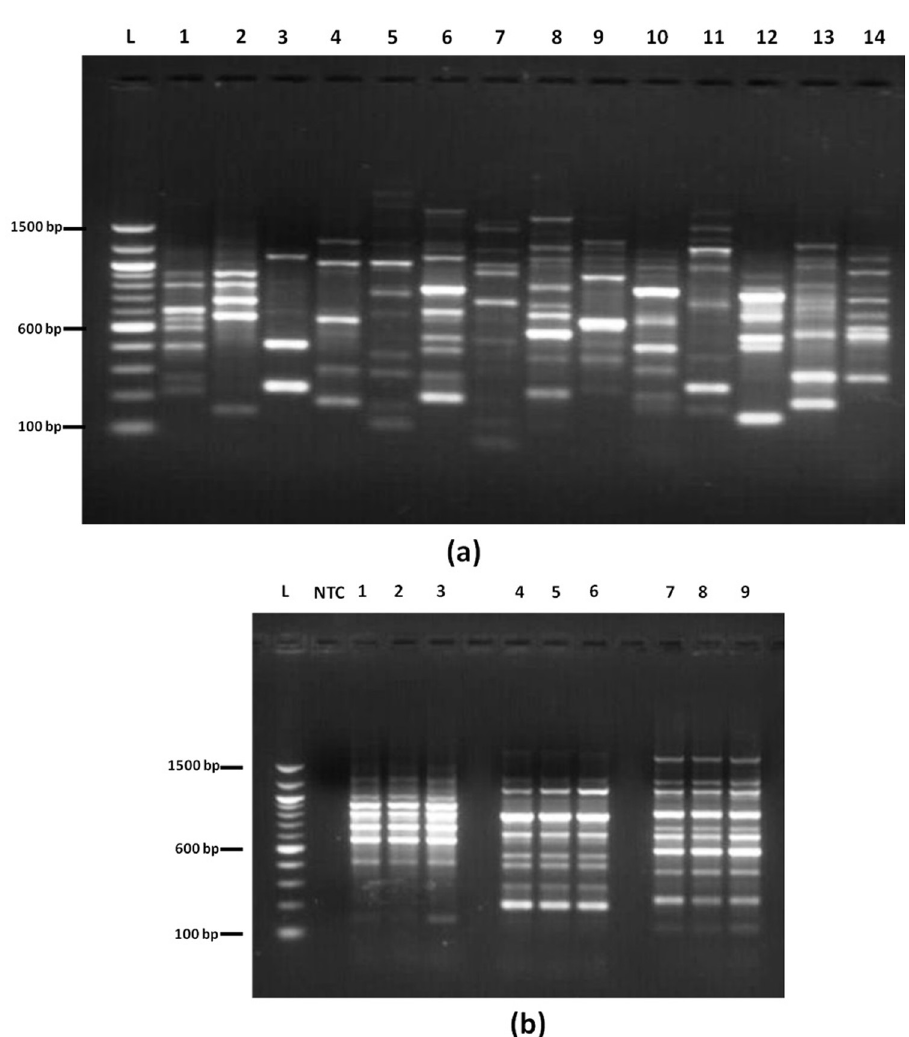
Fig 5. RAPD analysis of micropropagated Tylophora indica plants. (a) RAPD pattern as revealed by 14 different RAPD primers screened for number of scorable bands. L: 100 bp ladder; 1: OPA-05; 2: OPA-06; 3: OPA-08; 4: OPA- 14; 5: OPB-03; 6: OPB-10; 7: OPB-13; 8: OPC-08; 9: OPC-10; 10: OPC-15; 11: OPD-12; 12: OPD-20; 13: OPG-03; 14: OPH-02. (b) RAPD pattern of mother, in vitro and hardened plant of T . indica . (L: 100 bp ladder; NTC: no template control; 1–3: mother, in vitro and hardened plant, respectively with primer OPA-06; 5–7: mother, in vitro and hardened plant, respectively with primer OPB-10; 9–11: mother, in vitro and hardened plant respectively, with